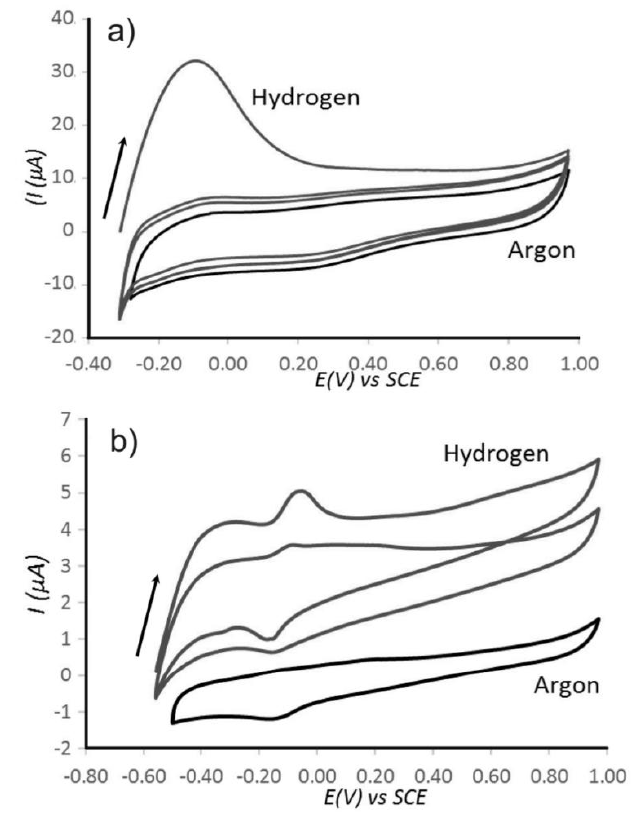
Figure 5. Cyclic voltammograms (scan rate 10 mV s −1 ) at Pt@cPIM immobilized onto a 3 mm diameter glassy carbon electrode immersed into ( a ) aqueous 0.1 M HClO 4 and ( b ) aqueous 10 mM PBS pH 7 solution purged with Ar or H 2 .